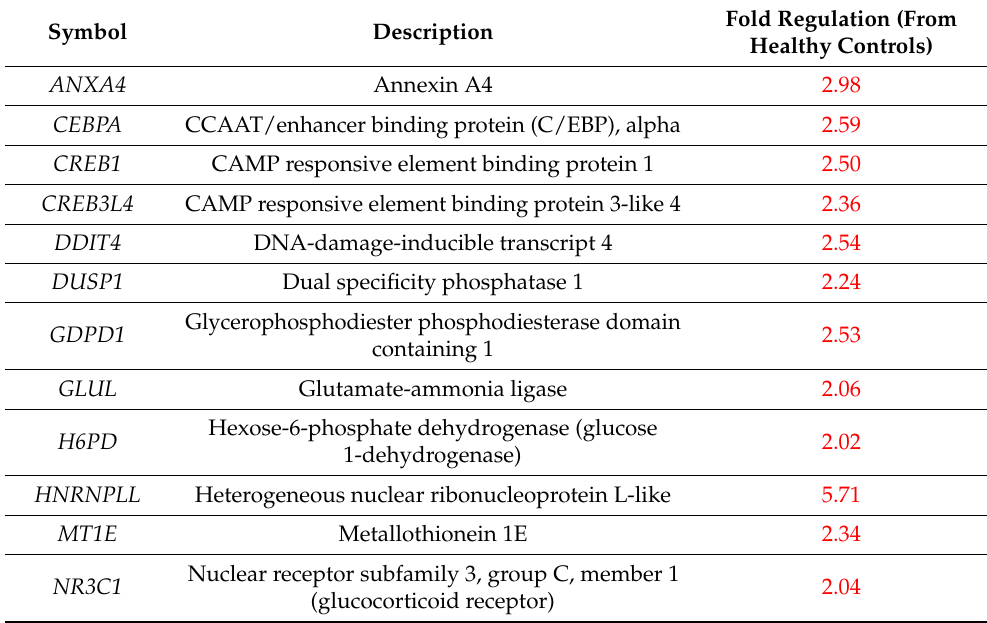
Figure 1. The glucocorticoid signaling pathway is altered in asthma. ( A ) Scatter plot showing distribution of up- and downregulated genes. ( B ) High-confidence (0.7) STRING network [20] of connected upregulated genes in individuals with asthma. ( C ) SGK1 is significantly increased in PBMCs from individuals with asthma (n = 17). Shown as fold change from healthy individuals (n = 4), normalized to 1. ** = p < 0.01. Table 2. List of genes at least 2-fold up- or downregulated in asthma compared to healthy individuals, identified by RT 2 profiler qPCR-based glucocorticoid signaling profiling array.